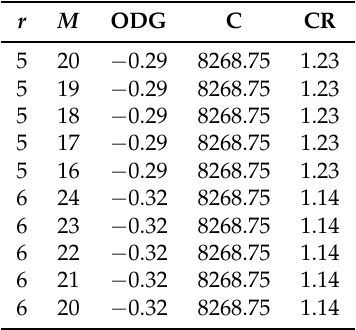
Table 5. 10 highest payloads.